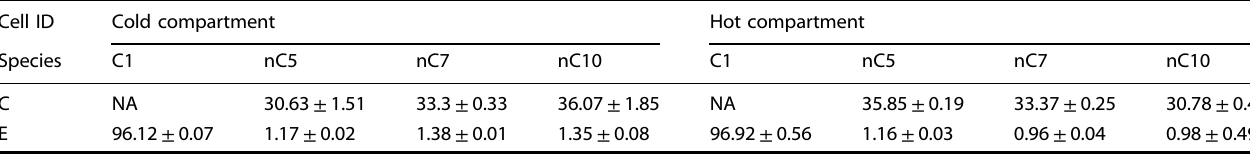
Table 2. Measured GC composition (in % mole fraction) in the two exploitable SCCO-SJ-10 cells after the fl ight. Initial compositions (before the fl ight) are provided in Table 1 Cell ID Cold